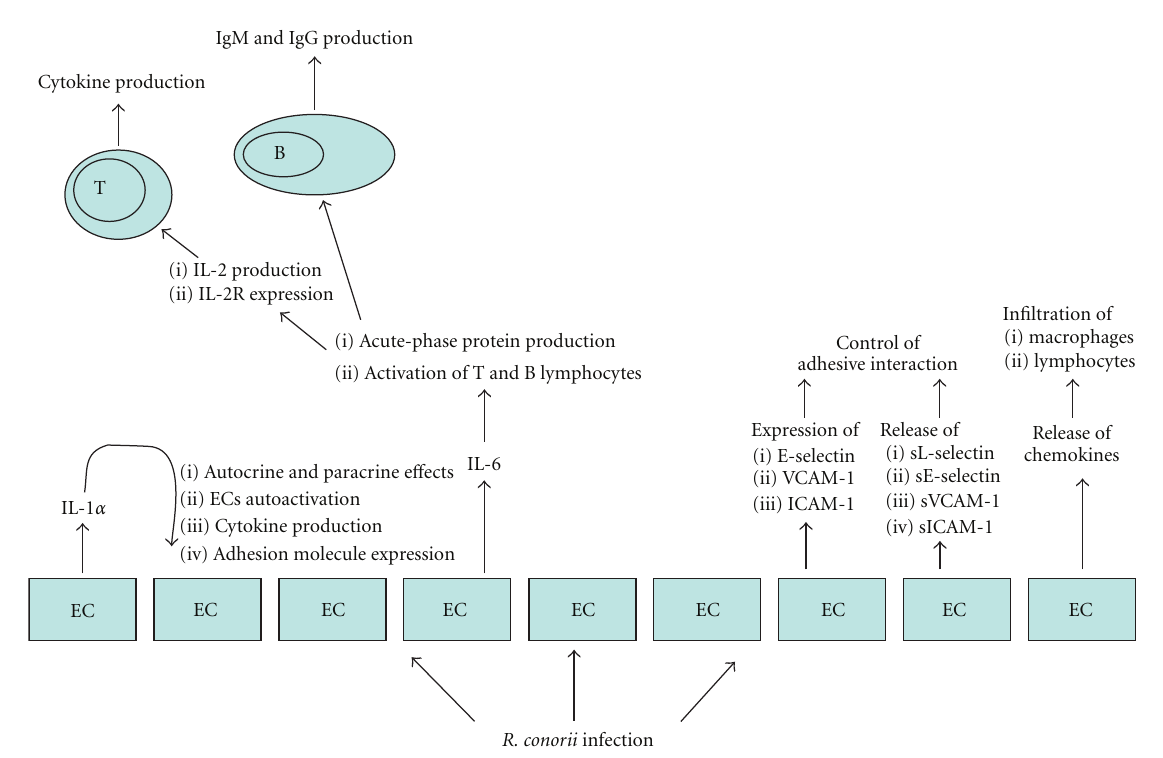
Figure 3: Cytokine production and induction of cellular adhesion molecules in rickettsial